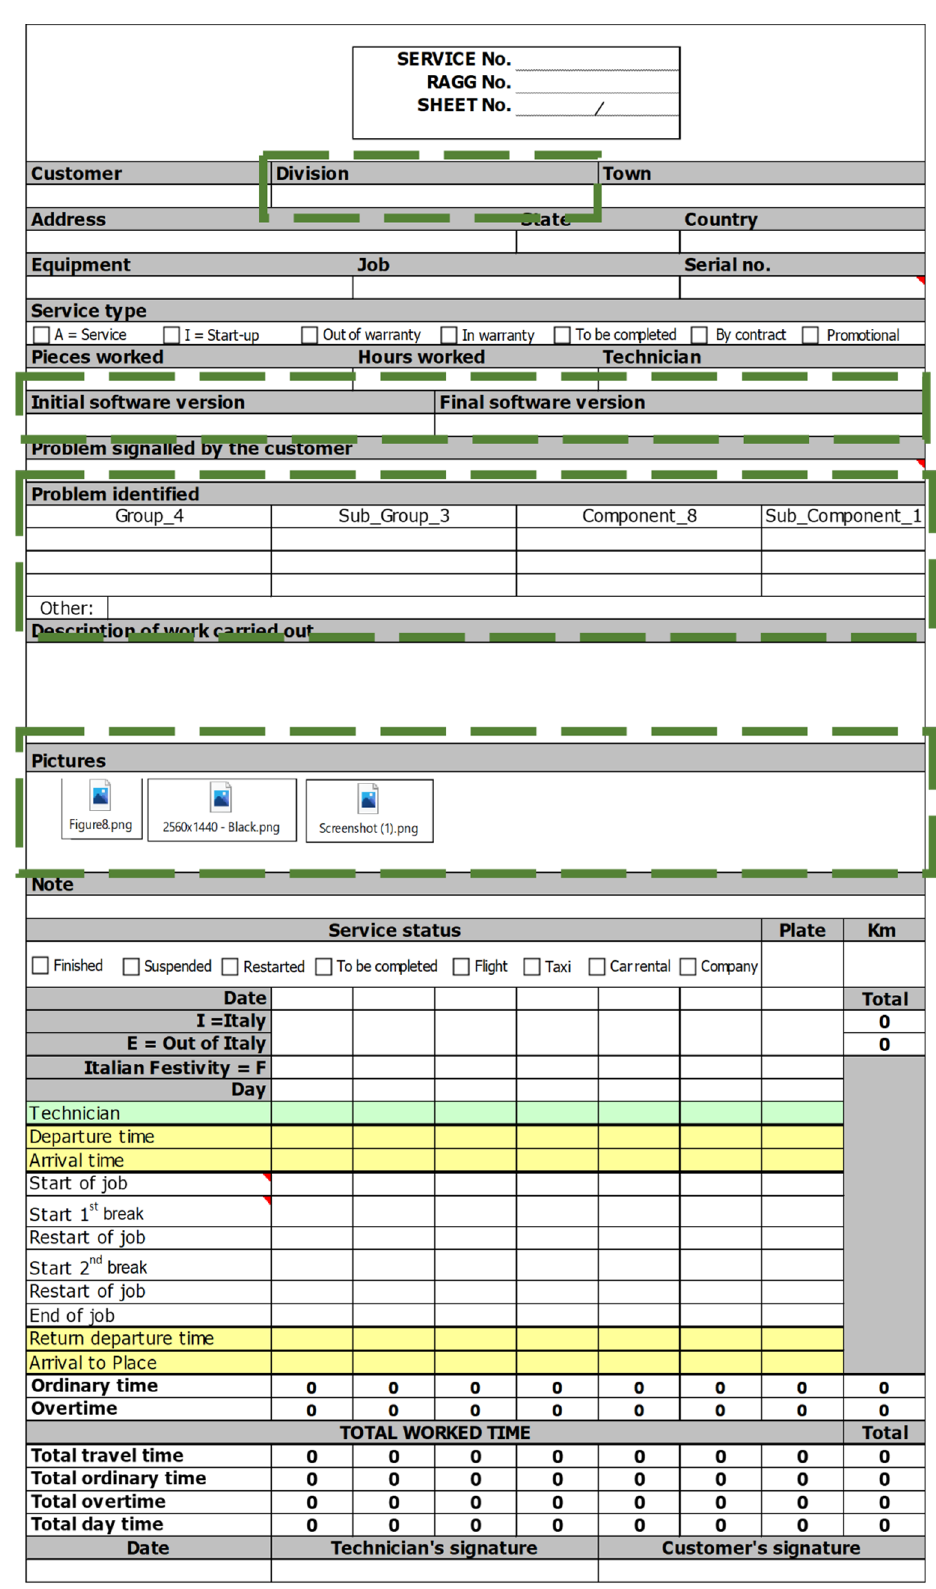
Figure 3. The new service report. Changes are highlighted in green rectangles. The figure is elaborated by the authors.